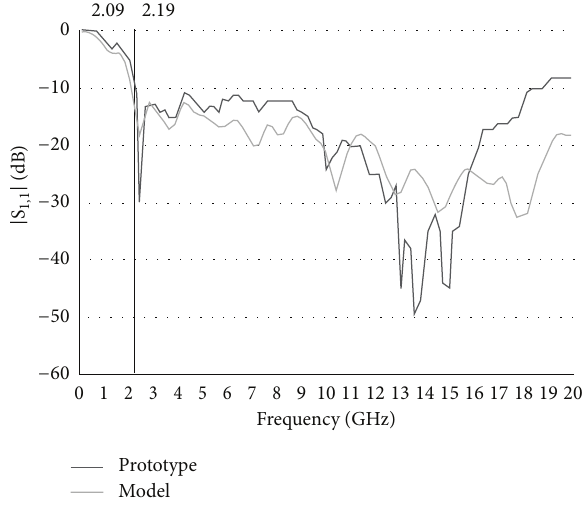
Figure 23: Simulated and measured reflection coefficient magni- tude of the proposed planar directional UWB antenna.